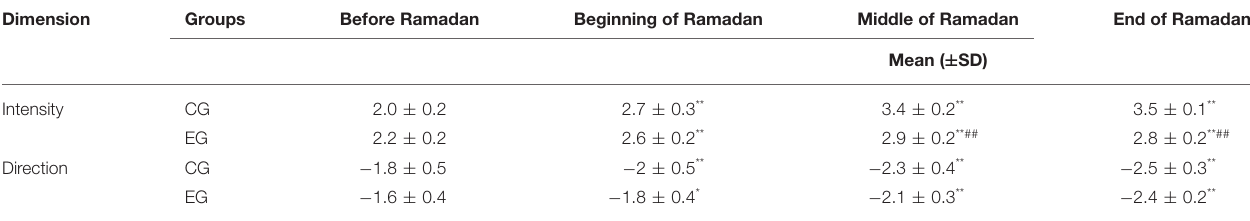
TABLE 4 | Variation in the dimensions of cognitive anxiety recorded before and during Ramadan.